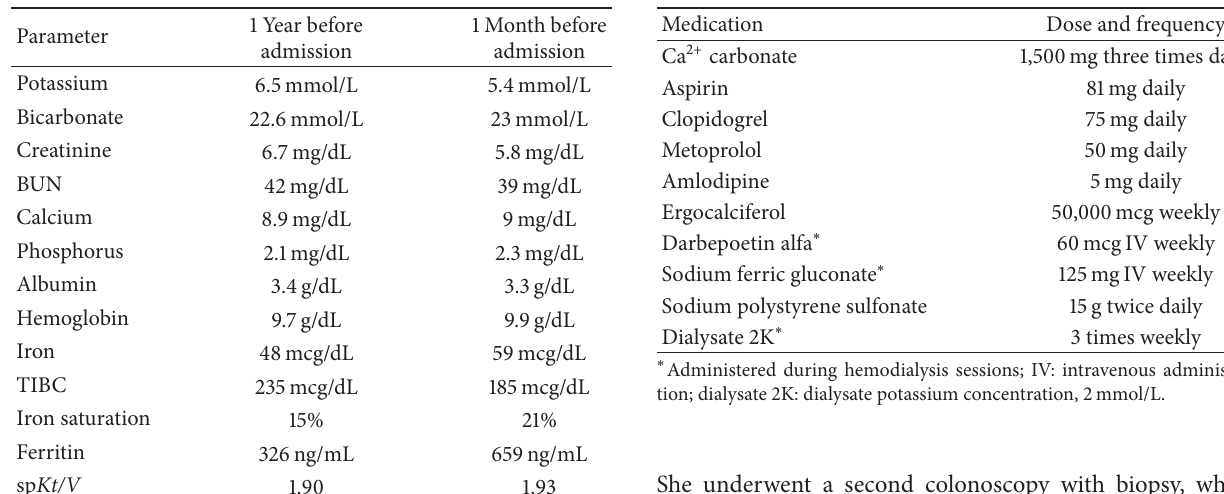
Table 1: Values of predialysis laboratory blood tests. Table 2: Medications received by the